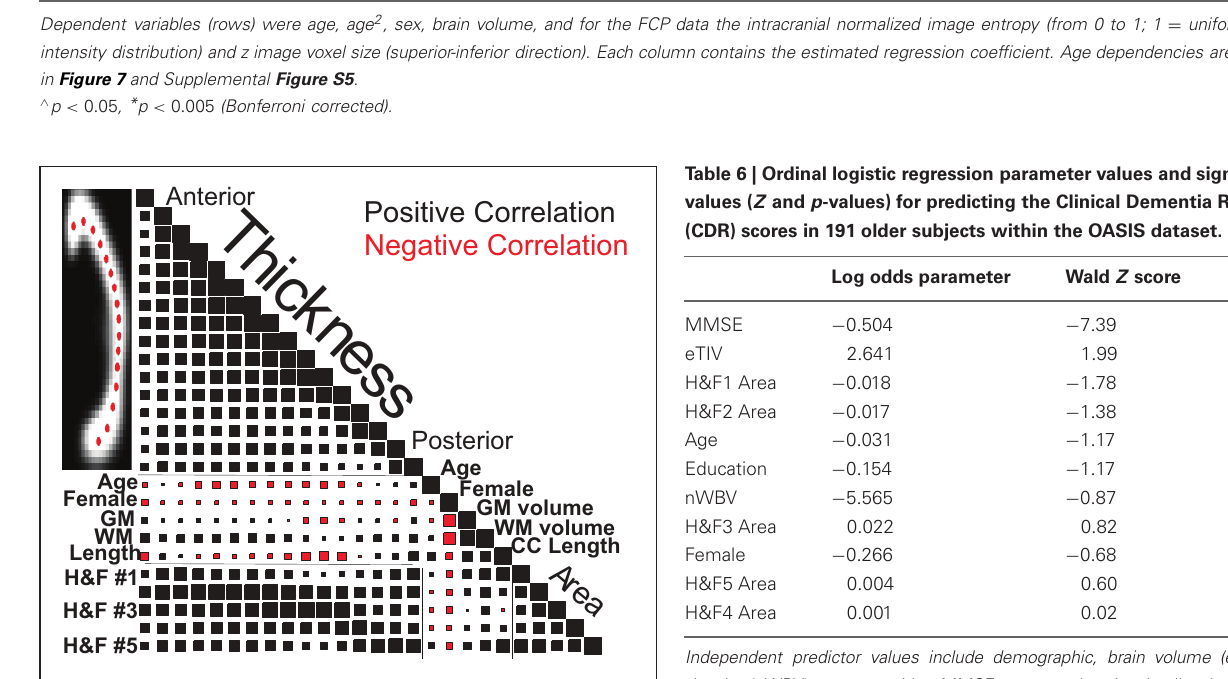
OASIS automated OASIS manual